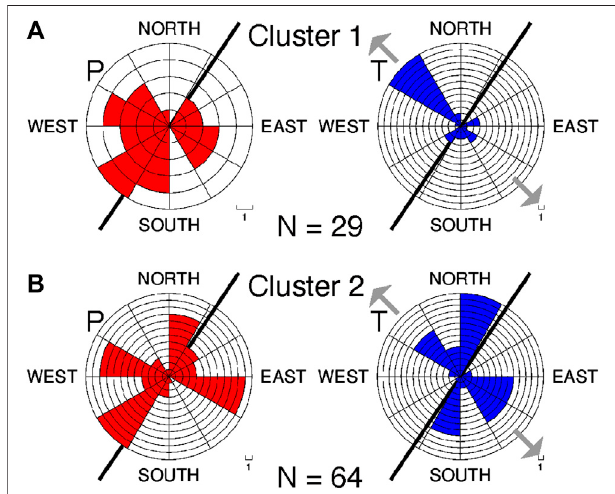
FIGURE 14 | Rose diagrams showing the frequency distribution of the azimuths of the P-axis (red) and T-axis (blue) for clusters 1 (A) and 2 (B) . The rosediagramshavea30 ° interval.Eachbinshowsonefrequency.Thenumber of events whose P- and T-axes were determined for each time period is also shown. The thick line in each diagram shows the strike direction of the dike source of the ground deformation associated with the VT earthquake swarm (Hotta et al., 2016a). Gray arrows indicate the azimuth of the regional maximum extension of the stress fi eld (Terakawa and Matsu ’ ura, 2010).